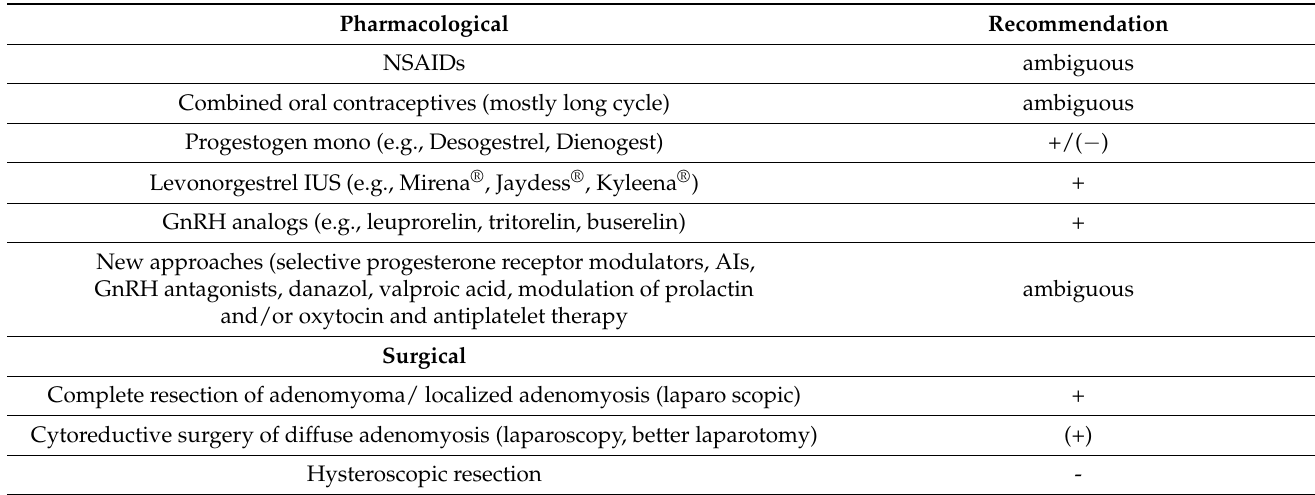
Table 3. Treatment options (including pretreatment) of adenomyosis in infertility